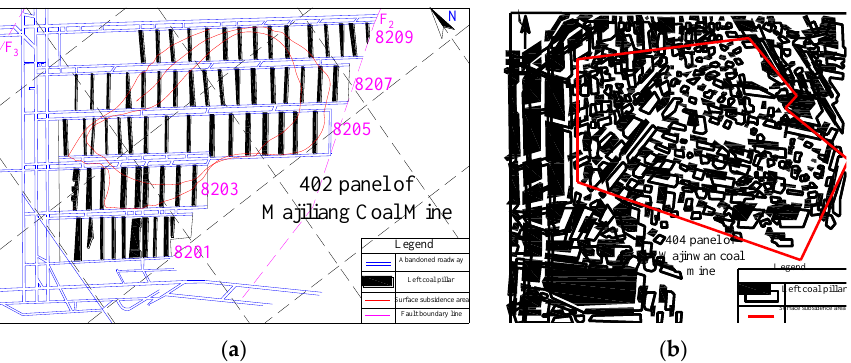
Figure 1. Surface collapsing induced by the failure and instability of left coal pillars in China [4]: ( a ) Surface collapsing induced by the failure and instability of left coal pillars in 402 panel of Majiliang Coal Mine; ( b ) Surface collapsing induced by the failure and instability of left coal pillars in 404 panel of Wajinwan Coal Mine.